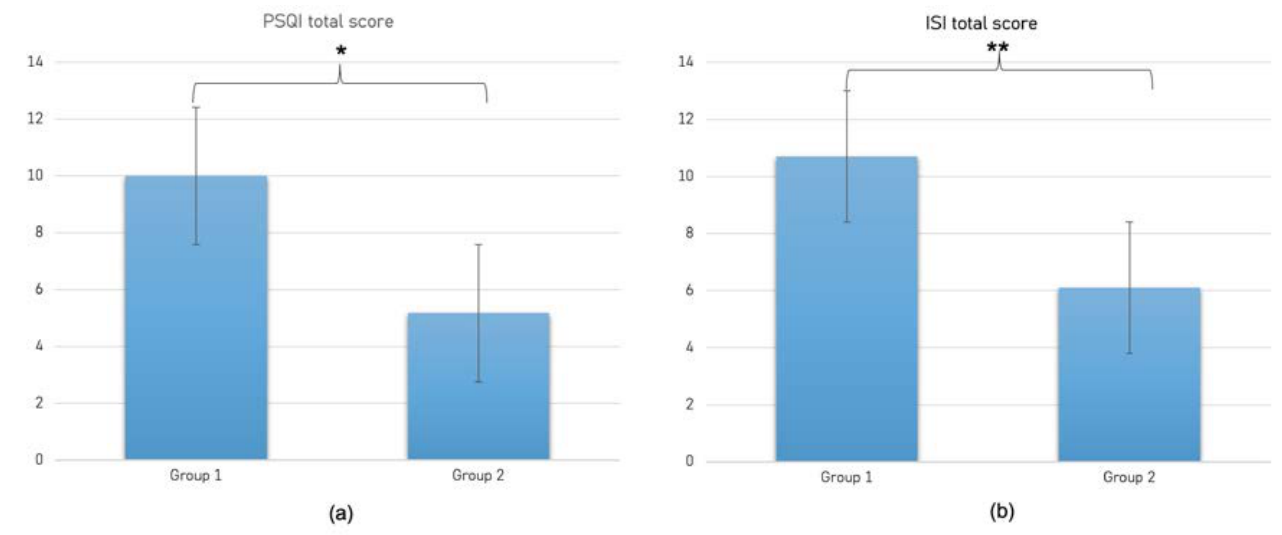
Figure 2. Comparison between Group 1 (prisoners) and Group 2 (controls) with respect to sleep quality as measured by PSQI (panel ( a )) and insomnia complaints as measured by ISI (panel ( b )); * p < 0.001; ** p = 0.005.